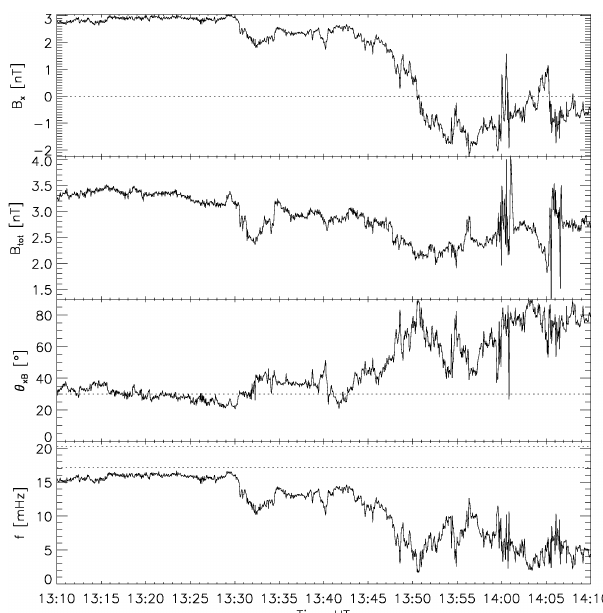
Fig. 8. Magnetic field data from GEOTAIL. The cone angle θ xB and the predicted upstream generated frequency f pred are shown in the two bottom panels. The two horizontal dotted lines in the bottom panel show the observed